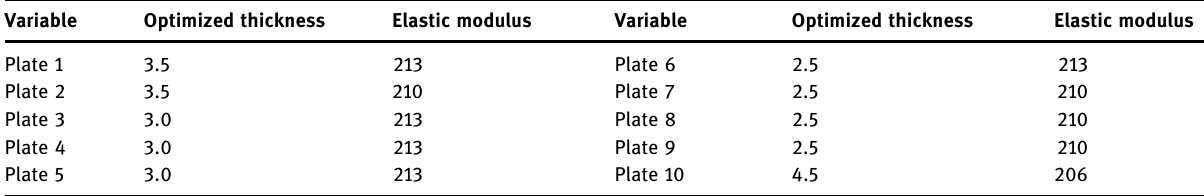
Table 5: Joint optimization results of sizes and materials